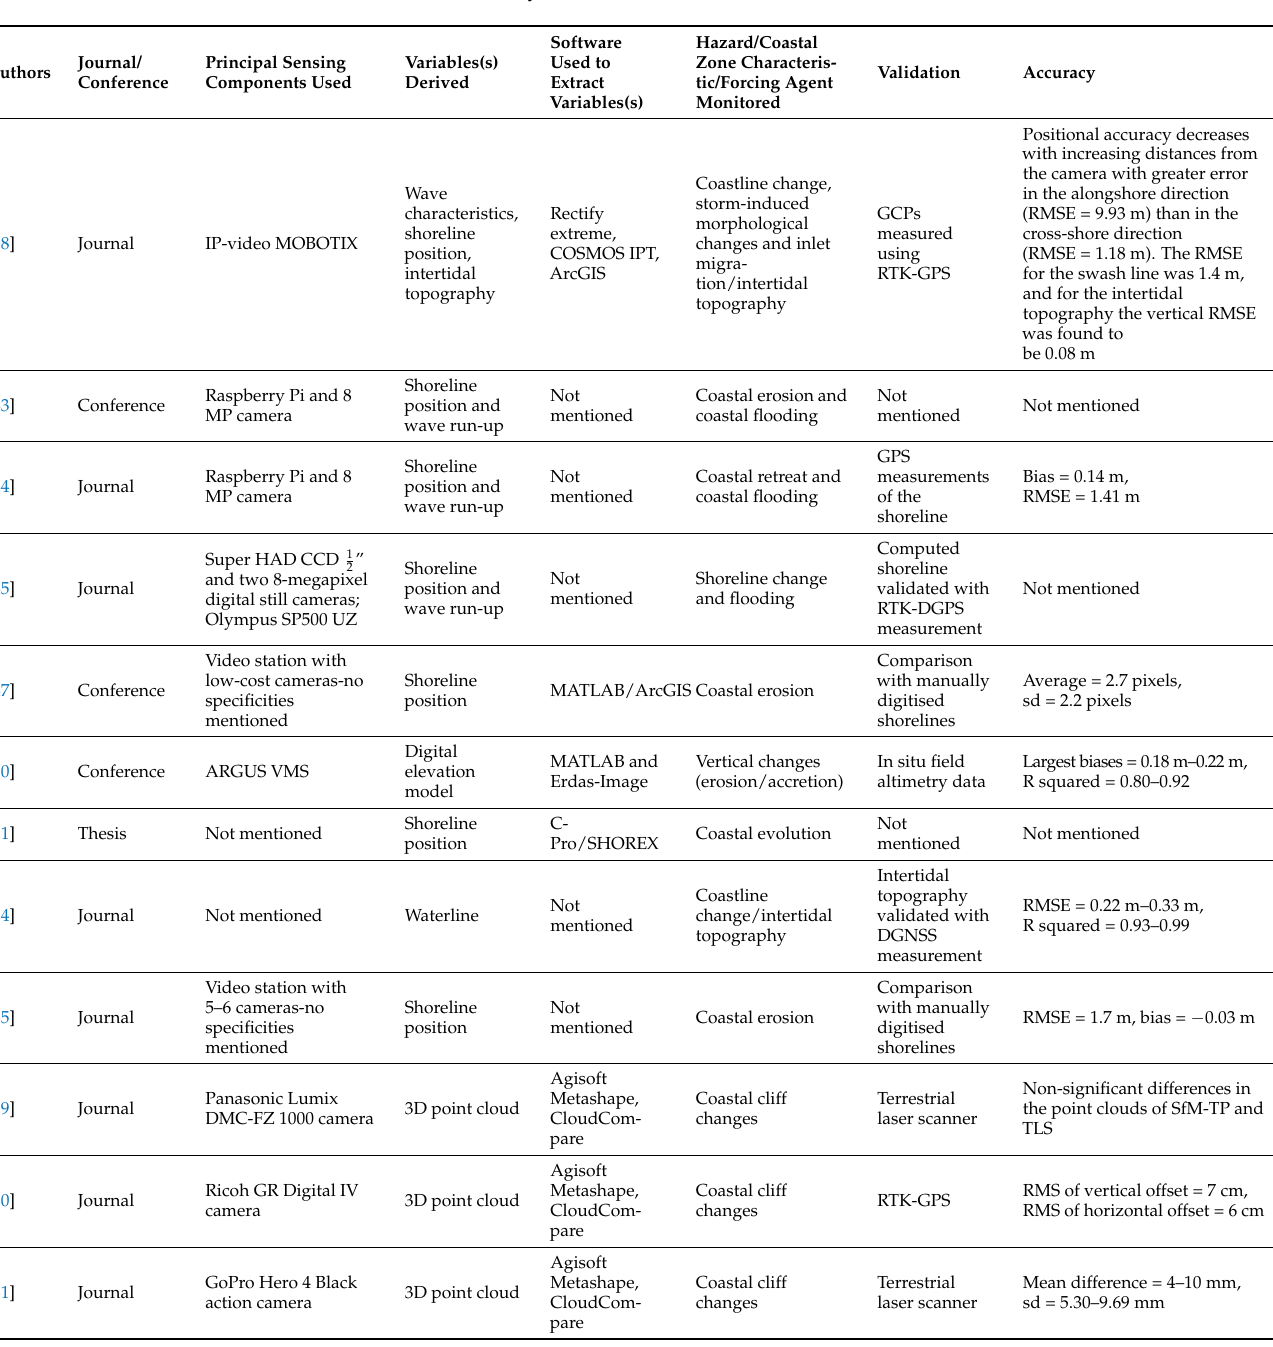
Table 3. Summary of papers on terrestrial photogrammetry that includes type of paper, sensors used, parameters derived, software used to extract parameters, hazards/forcing agents monitored, validation, and